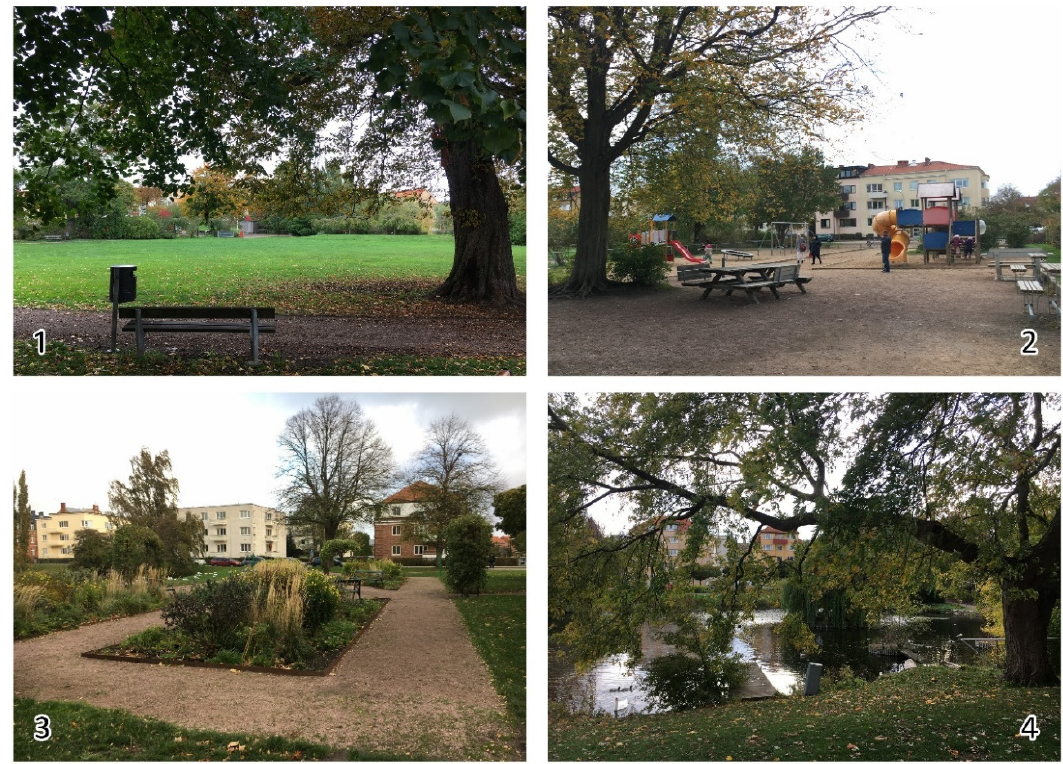
Figure 2. Parts of Wrangelska Parken. 1: open lawn area, with a path and a bench in the foreground, 2: playground with seating, 3: beds of perennials, 4: pond and bridge.